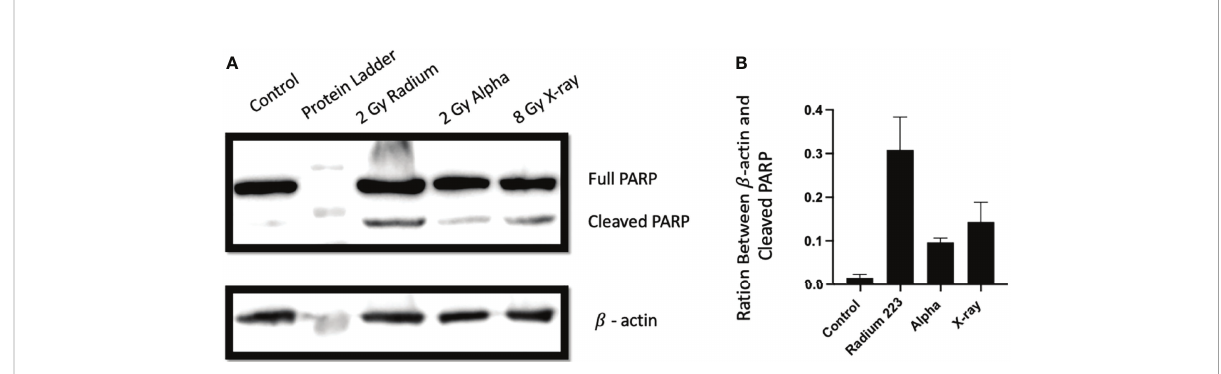
FIGURE 8 Different exposure conditions induce PARP cleavage in PC-3 24 h after irradiation. (A) Western blot demonstrating the protein expression of full and cleaved PARP-1 and b actin at 24 h following irradiation with 8 Gy of X-ray, 2 Gy of 223 Ra, or2 Gy of external alpha beam. (B) The ratio between cleaved PARP-1 and b actin (loading control). Bars represent the mean of two independent experiments and the respective standard